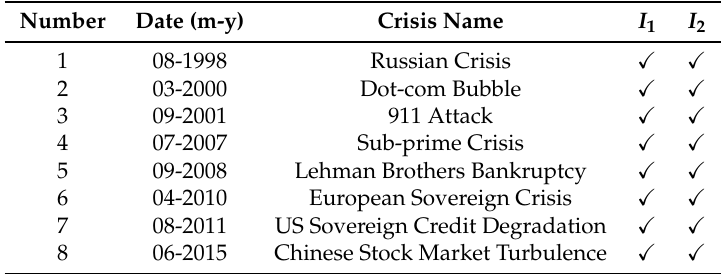
Table 1. Financial Drops vs. Reactive